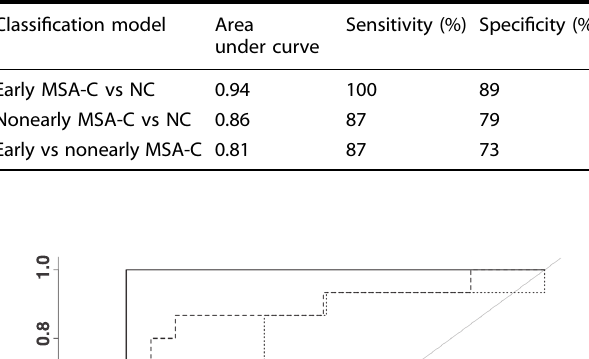
Table 3. Performances of discriminative analysis with support vector machine.